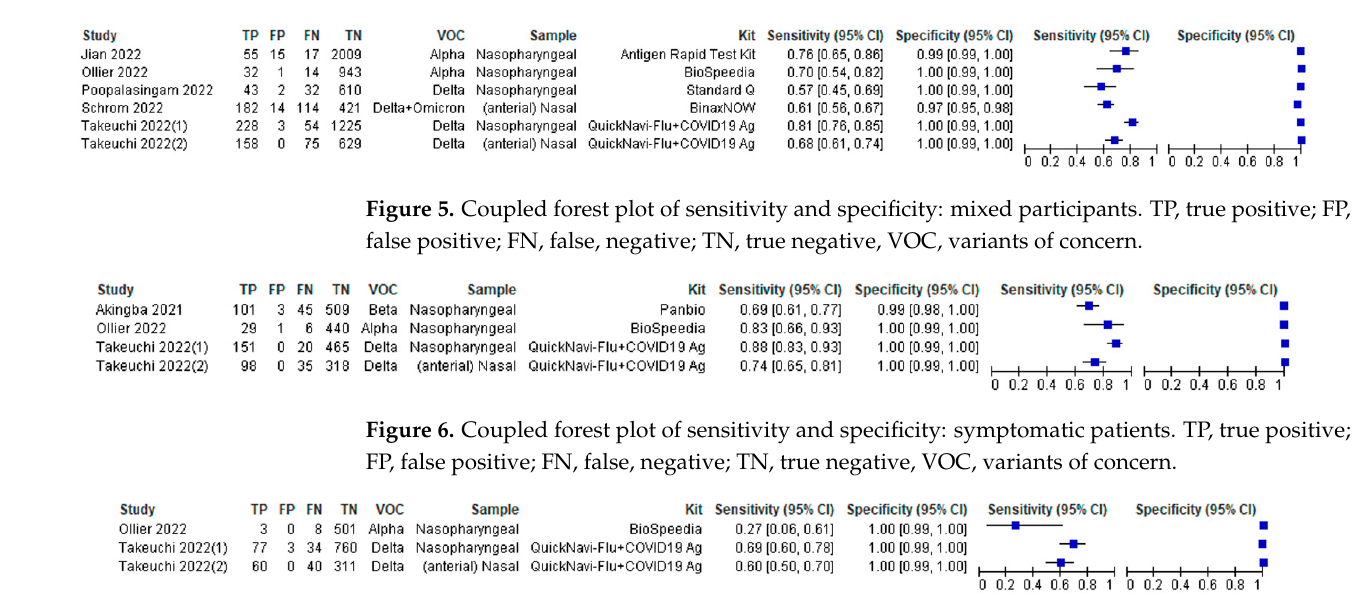
Figure 7. Coupled forest plot of sensitivity and specificity: asymptomatic individuals. TP, true positive; FP, false positive; FN, false, negative; TN, true negative, VOC, variants of concern.